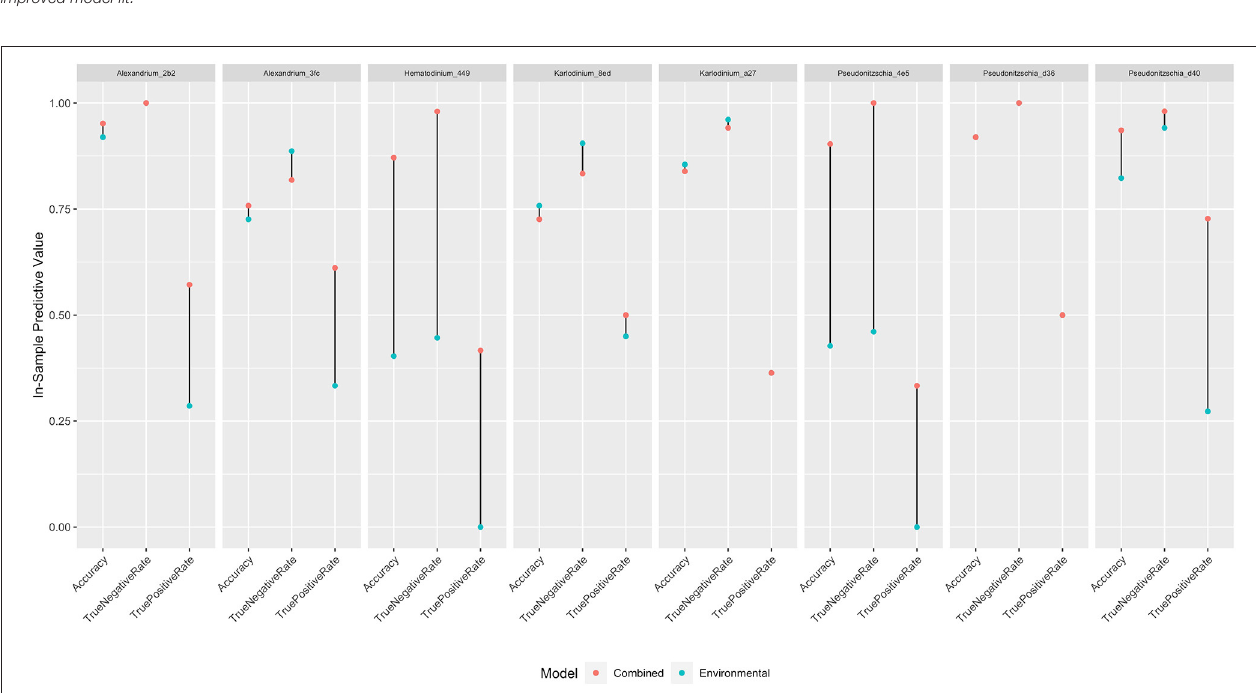
FIGURE 4 | In-sample predictive value of best-fit models for eight focal algal lineages, as measured by accuracy, true-negative rate, and true-positive rate. Red dots indicate values for models combining environmental information with a single associated predictor taxon; blue dots indicate values for models with environmental information alone. Where only a single dot is visible, models produced equivalent